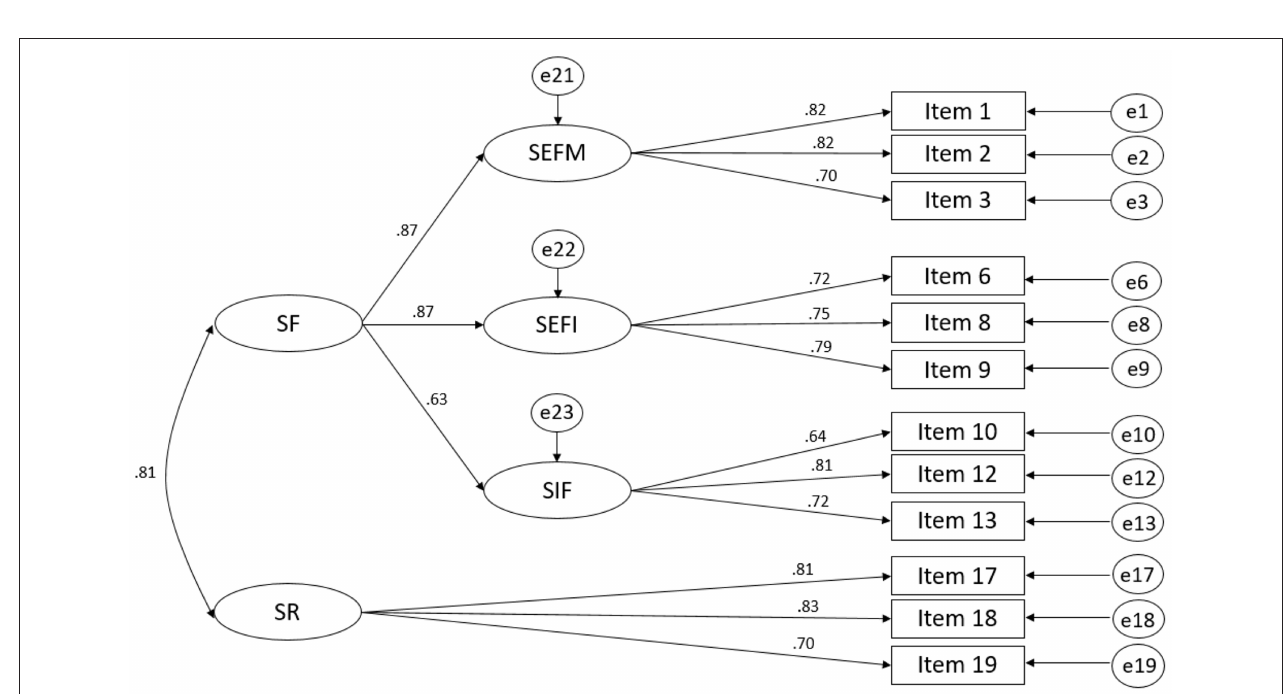
FIGURE 3 | Model 2 for the SaPS-SF with standardized factor